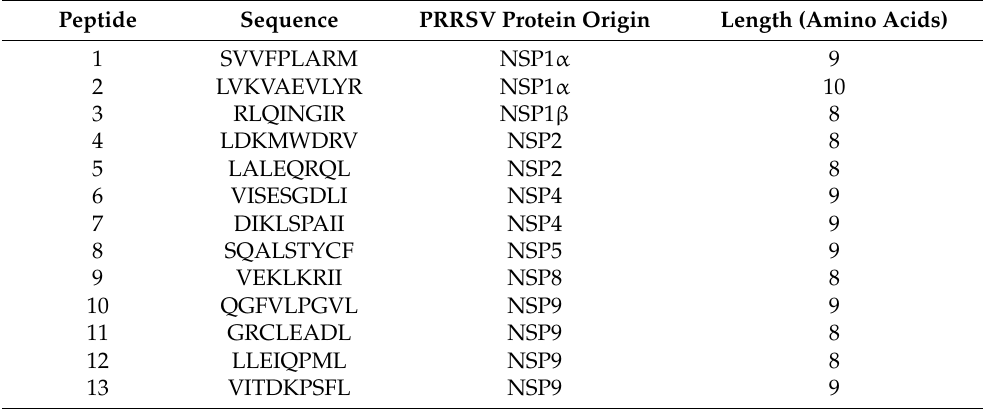
Table 2. Overview of the most confident hits of mass spectra obtained from the analysis of MHC-I- bound peptides of PRRSV-infected PAMs matched with the PRRSV genome.